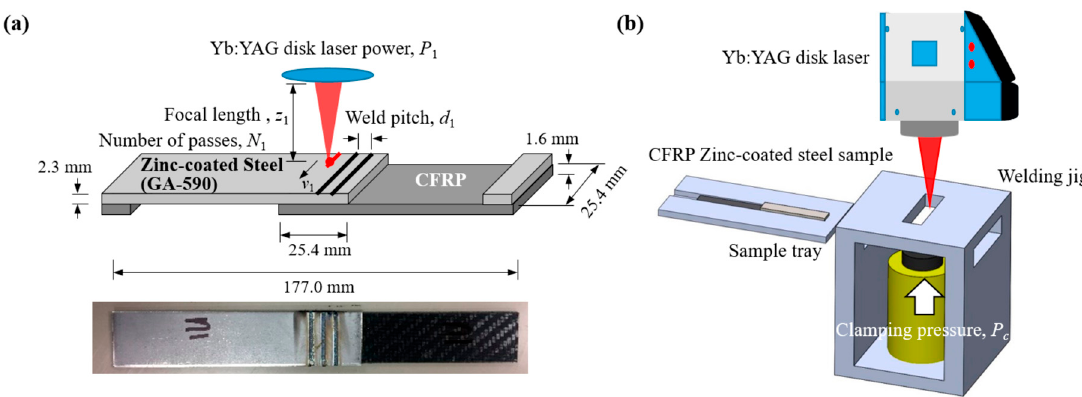
Figure 1. ( a ) Schematic diagram of the laser fusion welding of carbon fiber-reinforced plastic (CFRP) and zinc-coated steel and the welded sample. The laser fusion welding was done using a laser with a power of P 1 , a focal length of z 1 , and the number of passes as N 1 . ( b ) The custom-made jig design is also shown as a 3D rendering in which the samples are placed for the laser fusion welding process.